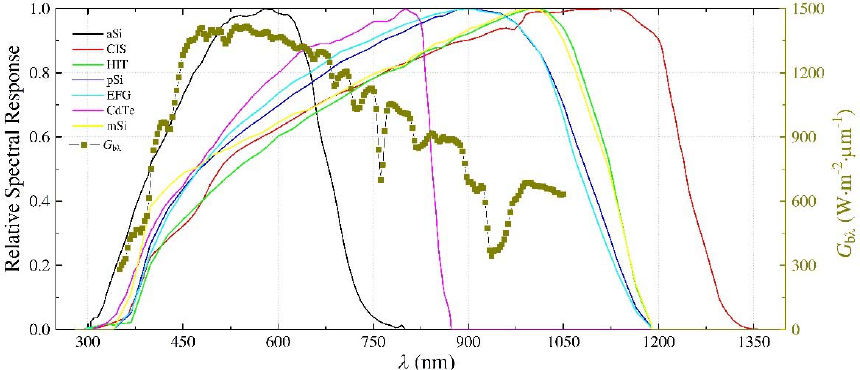
Figure 1. Relative spectral responses of seven PV technologies (left y-axis) over the 300 − 1350 nm waveband. The direct solar spectral irradiance G b λ measured at Huelva (Spain) with a tracking spectroradiometer at 1200 UT on 2021-03-24 is shown for reference (right y-axis). Based on the above considerations, it appears that the ideal experimental avenue would require either spectroradiometers covering a wider spectral range (with the incon- venience of increasing costs) or the development of algorithms that would expand the limited spectrum sensed by usual spectroradiometers and provide a reasonable irradiance estimate over the entire shortwave spectrum. Here, the la tt er hybrid (measurement + model) approach is explored, using a new methodology based on the Simple Model of the Atmospheric Radiative Transfer of Sunshine (SMARTS) spectral code (version 2.9.8) [18] to achieve four complementary goals: (i) extend the wavelength range of measured direct irradiance spectra from ≈ 1050 nm up to 4000 nm; (ii) substantially improve the spectral resolution of the spectroradiometers (typically 7 − 10 nm) to 1 nm for the end product; (iii) provide accurate estimates of the clear-sky broadband irradiances incident on horizontal or tilted planes; (iv) evaluate the magnitude and variability of the abundance of various atmospheric constituents. The la tt er goal would normally require local (and expensive) remote-sensing instrumentation, which is rarely available at solar laboratories. Since the abundance of key atmospheric constituents, such as aerosols, water vapor, or ozone, must fi rst be retrieved satisfactorily, this constitutes an interesting by-product in itself. In a sec- ond step, the expanded spectrum is calculated with SMARTS, using those retrievals. The SMARTS model’s conceptual idea is to o ff er fast and accurate predictions of spec- tral irradiance on any tilted surface without the di ffi culties and limitations associated with the atmospheric models such as MODTRAN [19] or libRadtran [20], which require a large amount of atmospheric information that is often unavailable at the site of interest. The SMARTS model is now widely used worldwide in a large variety of applications. This is made possible by the model’s versatility and accuracy, which has been abundantly vali- dated [21–23]. The model currently accommodates the case of cloudless skies only, for which it evaluates the clear-sky spectral irradiances (direct beam, circumsolar di ff use, hemispherical di ff use, and total on a prescribed receiver plane—tilted or horizontal) for speci fi c atmospheric conditions (user speci fi ed or selected from 10 standard atmospheres), and for one-to-many points in time or solar geometries. The algorithms were developed to match the output from the sophisticated MODTRAN band models within ≈ 2 %. The algorithms are implemented in compiled FORTRAN code for various platforms and are used in conjunction with data fi les describing the spectral variation of surface albedo and of the absorption of atmospheric components. The spectral resolution is 0.5 nm from 280 nm to 400 nm, 1 nm from 400 nm to 1750 nm, and 10 nm from 1750 nm to 4000 nm. The version 2.9.8 used here is intended for education and research and is free for use for these intended applications.